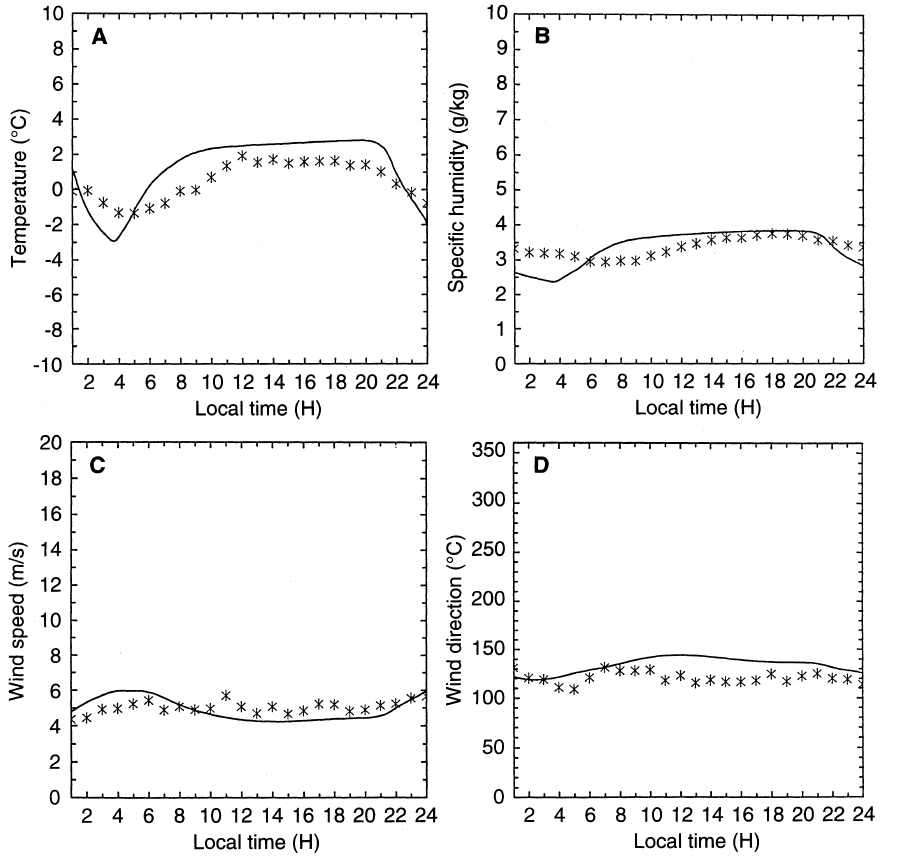
Fig. 8A–D. As in Fig. 7 but for A the 2 m temperature, B the 2 m specific humidity, C the 8 m wind speed and D the 31 m wind direction on July 12 from 0000 LST to